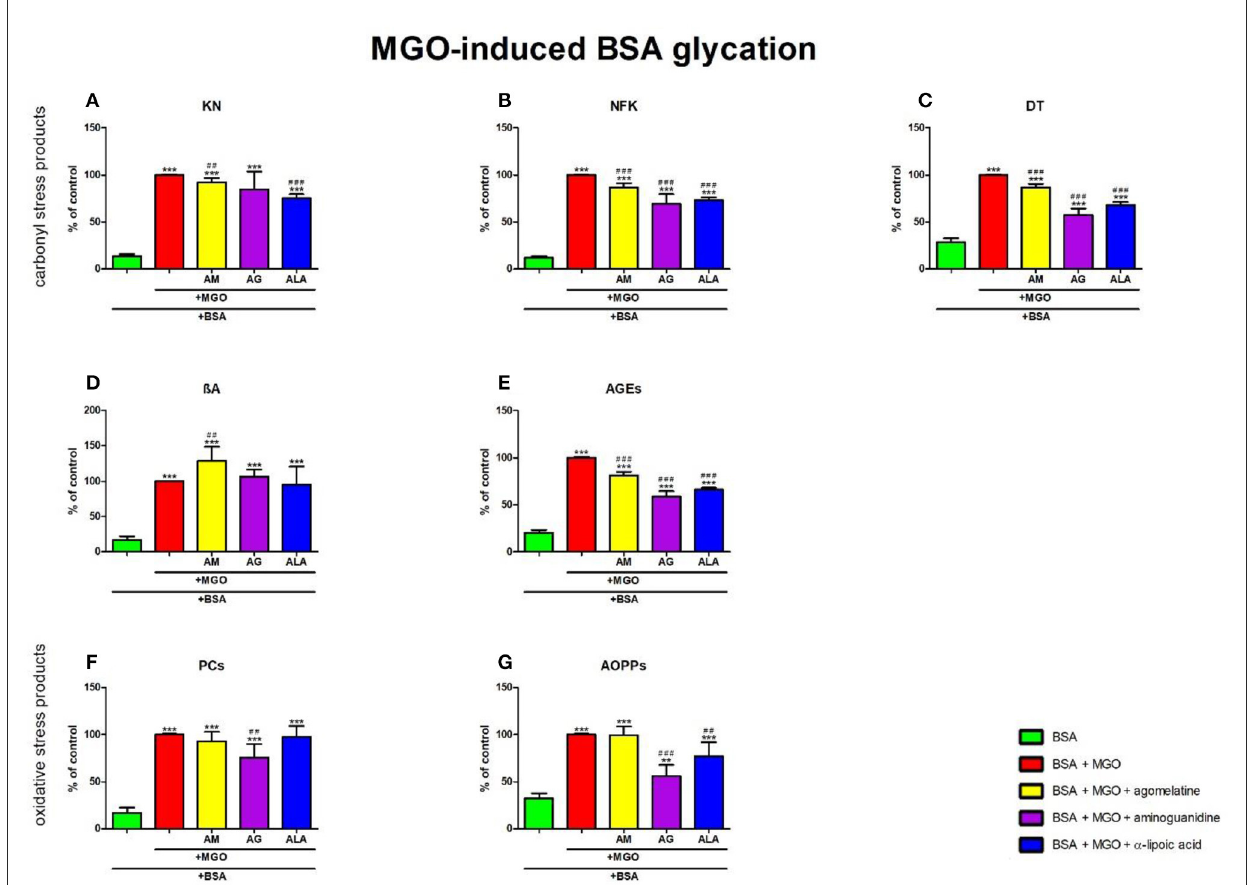
FIGURE9 Effects of agomelatine addition to methylglyoxal (MGO)-glycated bovine serum albumin (BSA) on carbonyl stress products (A–E) and oxidative stress products (F, G) . AG, aminoguanidine; AGEs, advanced glycation end products; ALA, α -lipoic acid; AM, agomelatine; AOPPs, advanced oxidation protein products; β A, β -amyloid; BSA, bovine serum albumin; DT, dityrosine; KN, kynurenine; MGO, methylglyoxal; NFK, N-formylkynurenine; PCs, protein carbonyls. ** p < 0.01 vs. negative control (BSA); *** p < 0.001 vs. negative control (BSA); ## p < 0.01 vs. positive control (BSA + MGO); ### p < 0.001 vs. positive control (BSA +